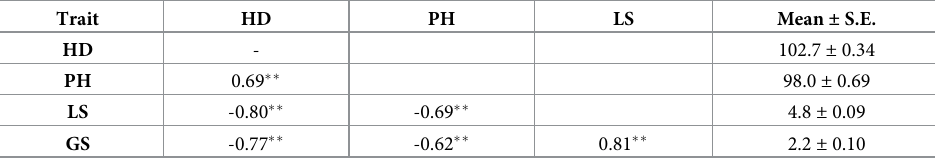
Table 1. Pearson’s correlation coefficients ( r ) and mean estimates with standard errors for heading date, plant height, and Septoria nodorum blotch leaf and glume disease severity in the GADH